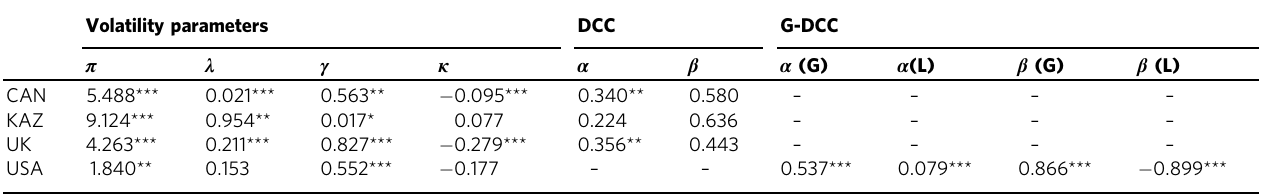
Table 8 Empirical results of GJR-GARCH-DCC